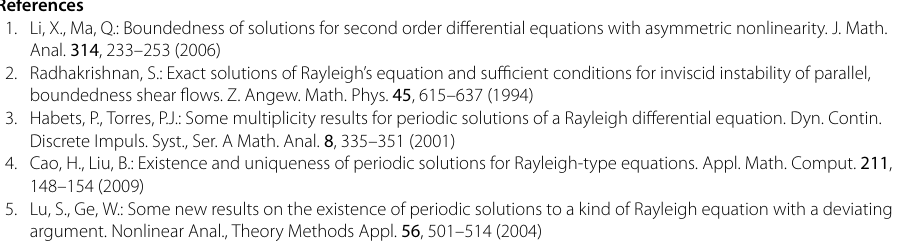
Figure 8 The phrase plan ( x 4 ( t ), y 4 ( t